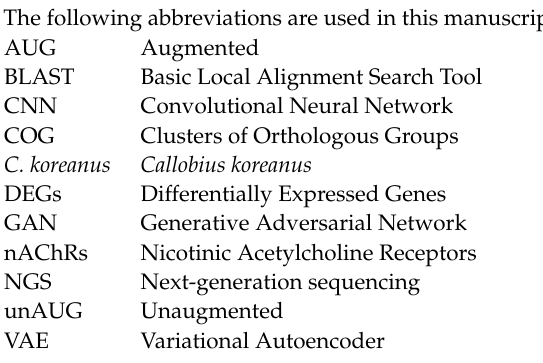
with the simulation data; Figure S4: Prediction results from the AUG CNN model group with the test data; Figure S5: Prediction results from the AUG CNN model with the simulation data; Figure S6: Preprocessing of C. koreanus transcriptomic data; Figure S7: Reproducibility among C. koreanus samples; Figure S8: DEG analysis of C. koreanus transcriptomic data; Figure S9: Functional annotation of the clustal of orthologous groups (COGs) from C. koreanus peptide-coding genes; Figure S10: Functional annotation of gene ontology (GO) from C. koreanus peptide-coding genes; Figure S11: Distribution of the level-2 GO terms of C. koreanus peptide-coding genes; Figure S12: Comparison of C. koreanus transcriptome between the DEGs and prediction results from the AUG CNN model; Figure S13: Evaluation of cytotoxicity of the peptides against human neuroblastoma cell line; Table S1: Dataset information; Table S2: CNN model hyperparameters; Table S3: